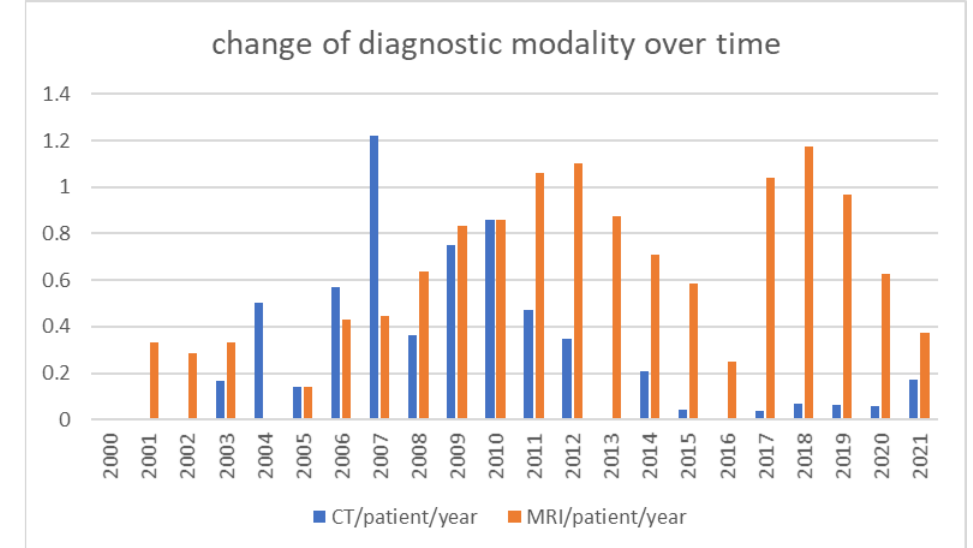
Figure 3. Change in diagnostic modality over time. Values present the rates of cCTs and MRIs per patient for the indicated year.